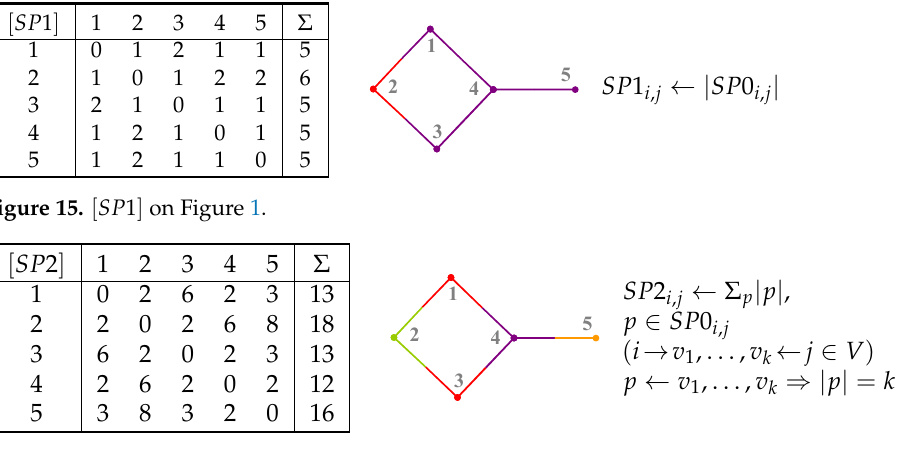
Figure 16. [ SP 2 ] on Figure 1.